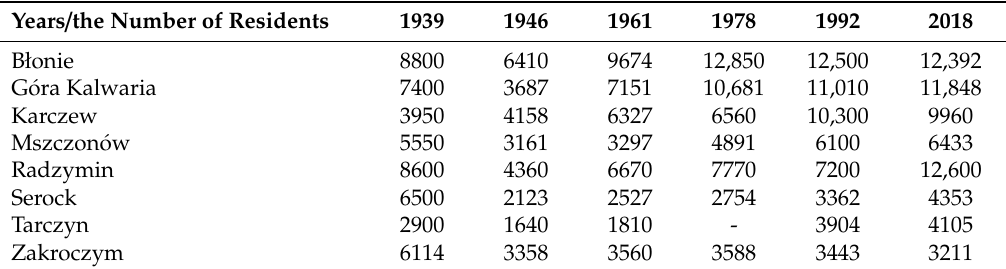
Table 2. Changes in the population of selected cities.